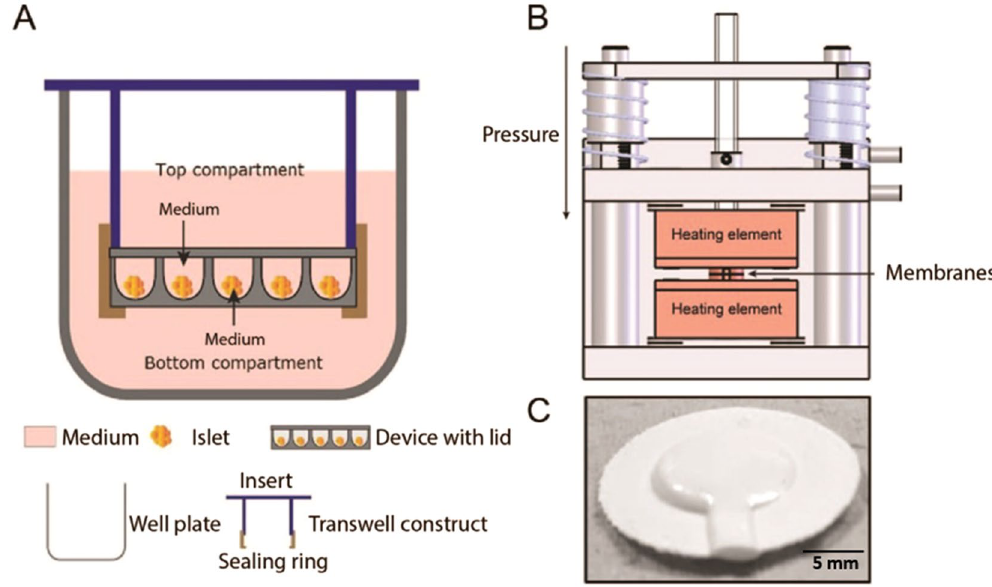
Figure 7. Experimental setup. ( A ) Schematic representation of two-compartment transwell system, ( B ) Schematic overview of the custom made sealing machine. Two Teflon coated heating elements with a circle with a small opening were used to obtain a seal between the microwell membrane and the PES lid, ( C ) The sealed